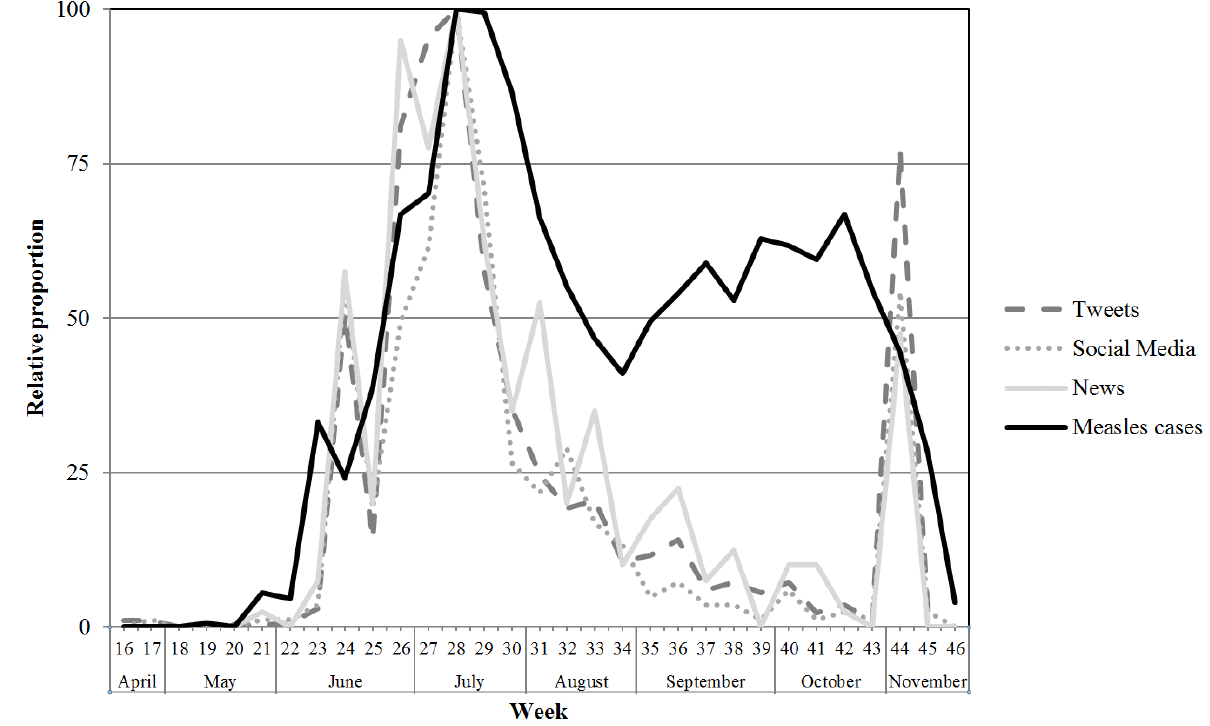
Figure 1. Comparison of relative proportions of weekly tweets, other social media messages, and online newspaper articles to measles cases from April 15 to November 11, 2013. Graph is scaled to the highest peak at week 28 for all 4 data sources (peak assigned a score of